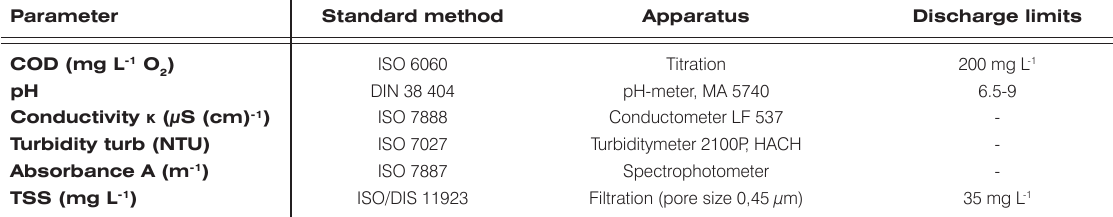
Table 1. Measured parameters, standard analytical methods and